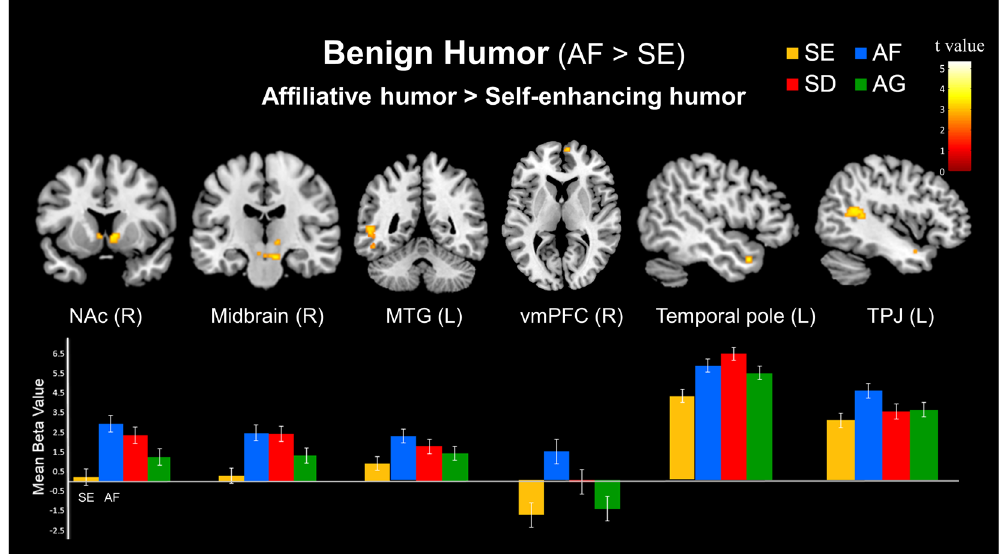
Figure 4. Simple effects of the differential neural mechanisms related to benign humor. (Top) Stronger responses to affiliative humor (AF) than to self-enhancing humor (SE) in the right nucleus accumbens (NAc), right midbrain, left middle temporal gyrus (MTG), right ventromedial prefrontal cortex (vmPFC), left temporal pole, and left temporoparietal junction (TPJ). (Bottom) Parameter estimates (SPM betas) are plotted for these six regions. Standard error bars are